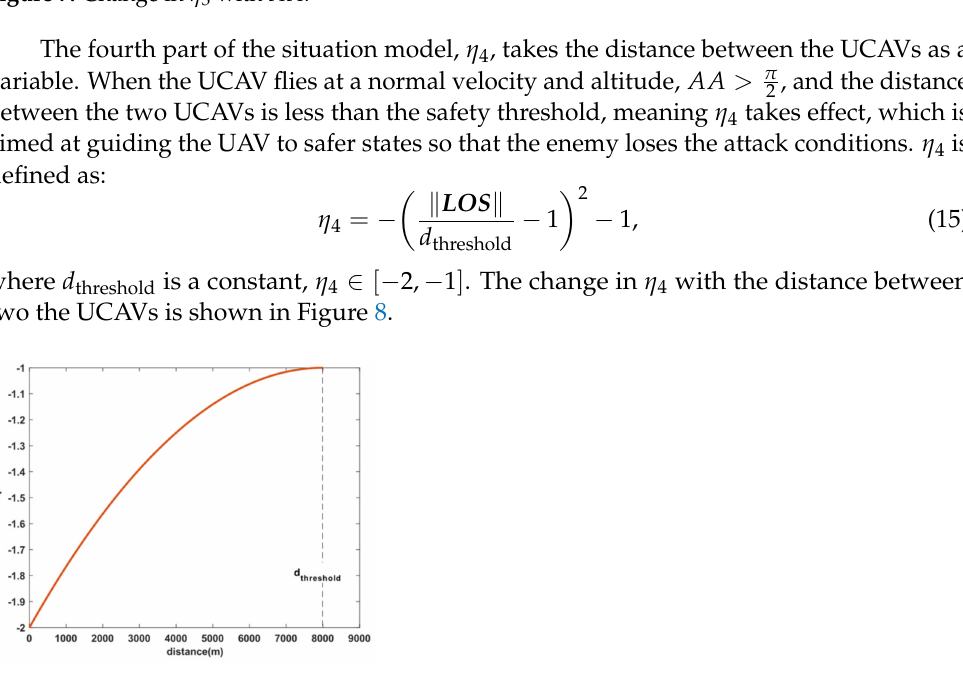
Figure 8. Change in η 4 with the distance between two